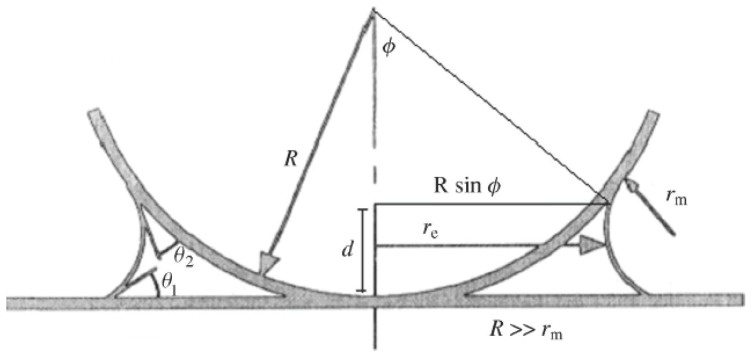
Schematic view of a water meniscus between a sphere with radius R and a plate (Reproduced by permission of Taylor and Francis Ltd. [29]).